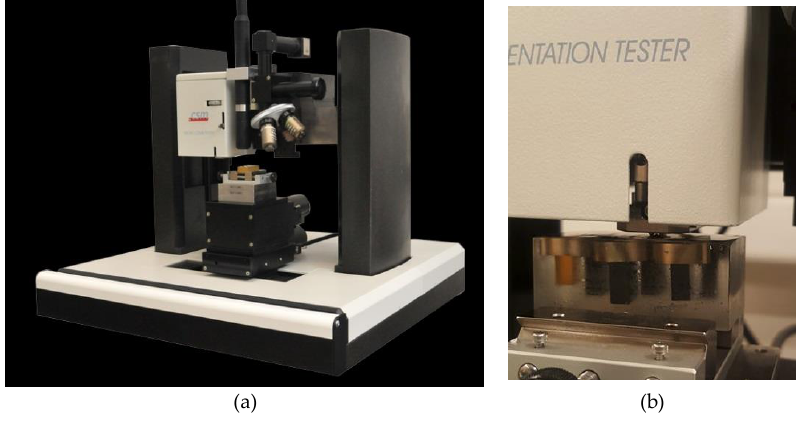
Figure 5. Image of ( a ) the indentation machine and ( b ) specimens under test.